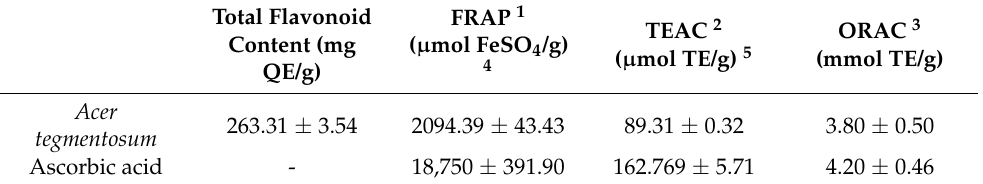
Table 7. Total flavonoid content and antioxidant activity of A. tegmentosum extract.